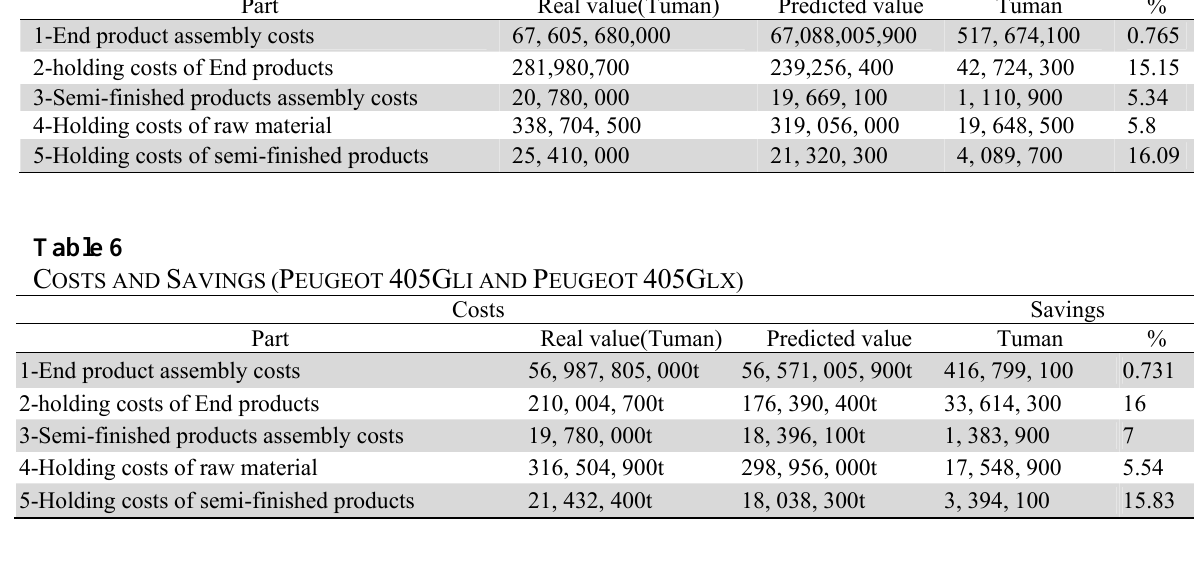
Costs and Savings (Peugeot 405Gli and Peugeot Pars)